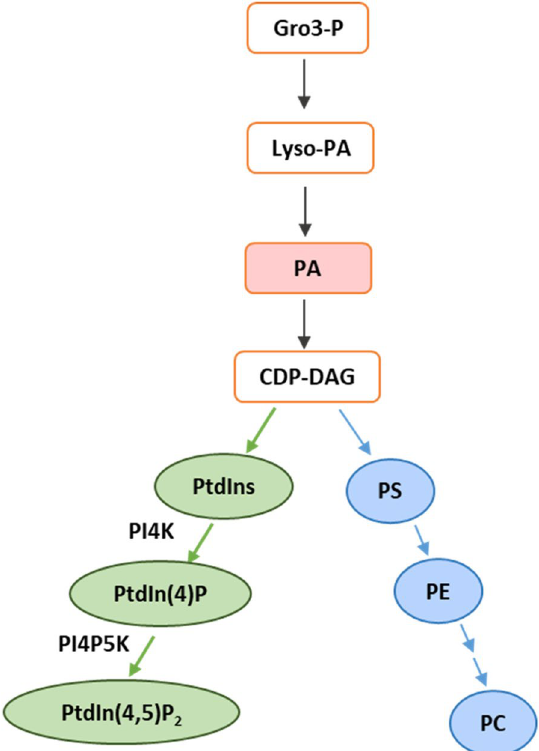
Fig. 1 Pathway for the biosynthesis of phosphoinositides. Phosphoinositides are synthesized via the cytidine diphosphate–Diacylglycerol (CDP-DAG) pathway. Gro-3-P, glycerol-3-phosphate; Lyso-PA, lysophosphatidic acid; PA, phosphatidic acid; CDP-DAG, cytidine diphosphate diacylglycerol; PtdIns, phosphatidylinositol; PI4K, Phosphatidylinositol-4 kinase; PI4P or PtdIn(4)P, phosphatidylinositol-4-phosphate; PI4P5K, phosphatidylinositol 4-phosphate 5-kinase; PI(4,5)P 2 or PtdIn(4,5)P 2 , phosphatidylinositol-4,5-bisphosphate; PS, phosphatidylserine; PE, phosphatidylethanolamine; PC,